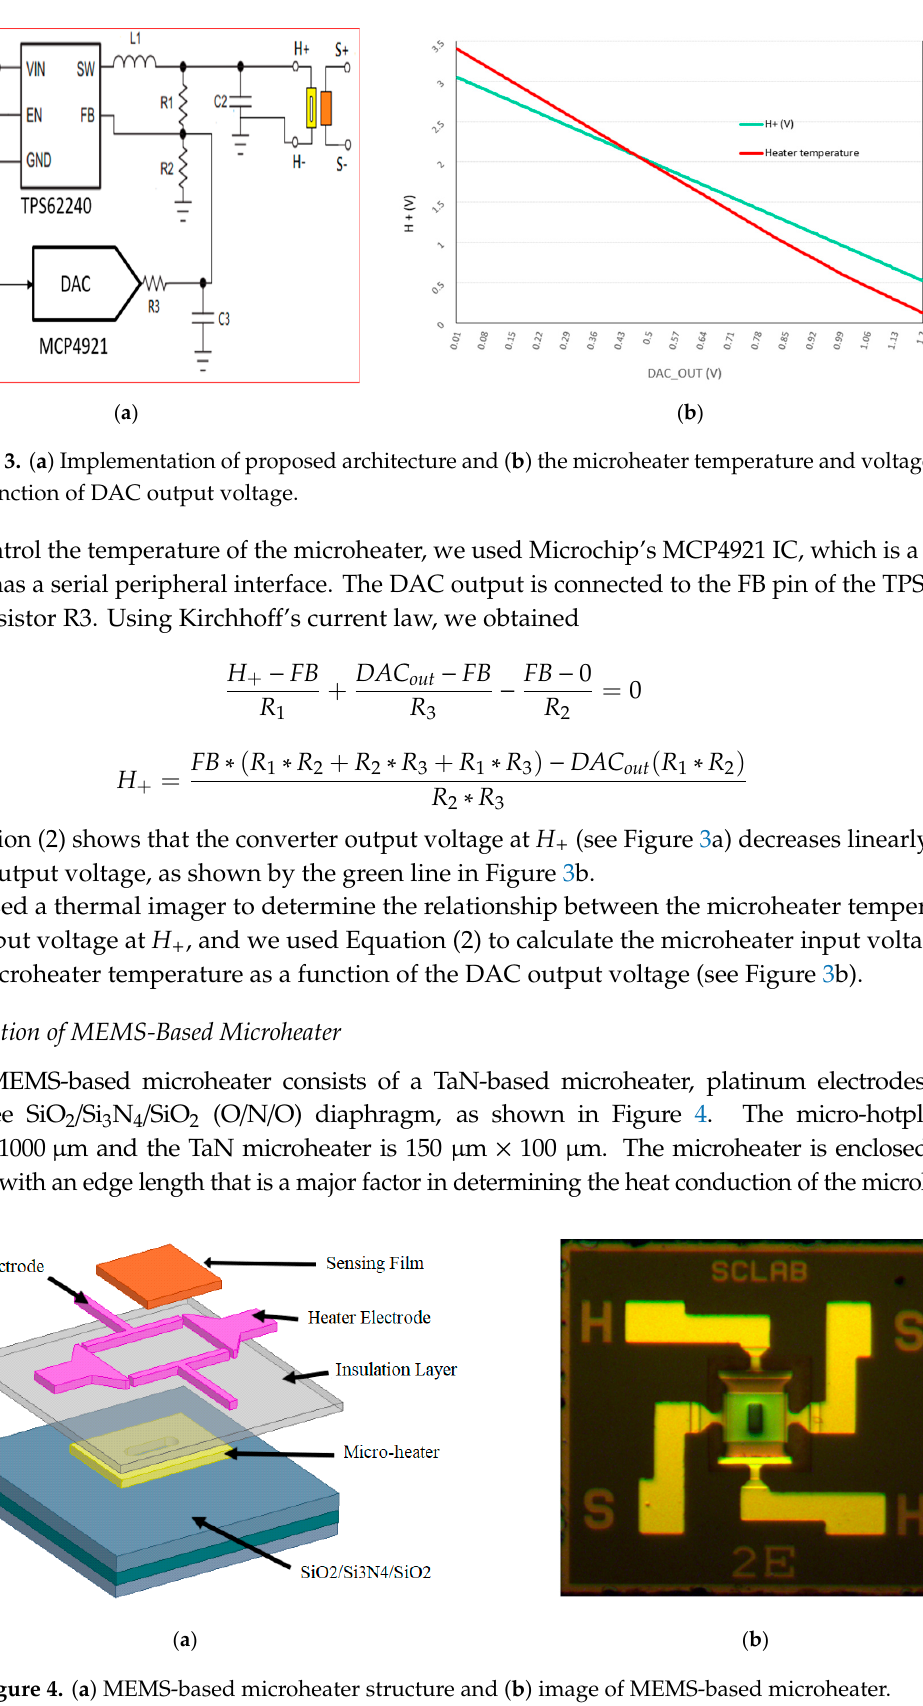
Figure 4. ( a ) MEMS-based microheater structure and ( b ) image of MEMS-based microheater.